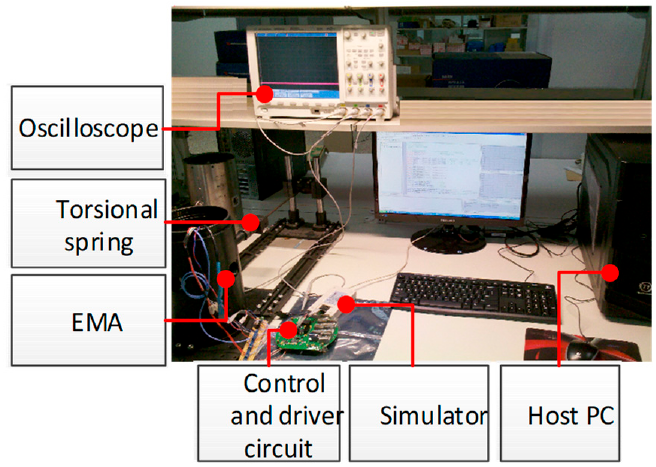
Figure 16. Step response with disturbance.